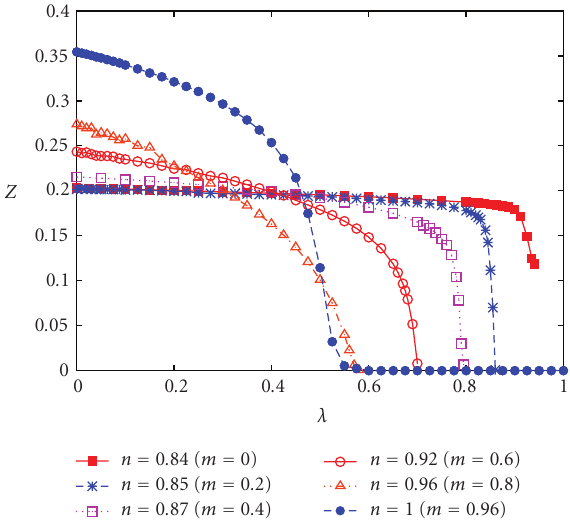
Figure 12: Quasiparticle renormalization as a function of λ for di ff erent values of the density n (and consequently di ff erent magnetization m ) at fixed U = 1 . 75 W and ω 0 = 0 . 0125 W (after Sangiovanni et al.